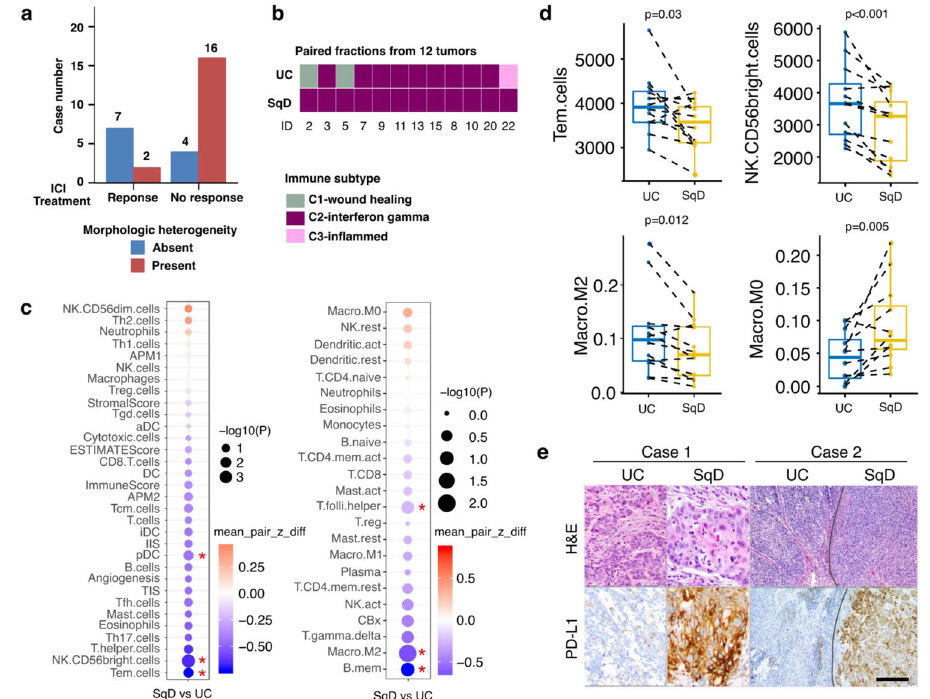
Fig. 4 | Distinct immune response gene signatures in paired UC and SqD sam- ples. a Morphologic heterogeneity was associated with a lack of clinical bene fi t in bladder cancer patients treated with the anti-PD-L1 antibody atezolizumab( n =29) ( p =0.01, Fisher ’ s exact test). b RNAseq data was used to classify the UC and SqD componentsfromthe12UC-SqDpairsbasedonTCGAimmunesubtypes. c Immune cell deconvolution analysis was performed using single sample Gene Set Enrich- ment analysis (ssGSEA, left) or the CIBERSORTX algorithm (right). The size of the circles is re fl ective of the p -value and the red * indicates signi fi cantly enriched immune cellsin either the SqD or UCfractions (two-sided Paired sampleWilcoxon test). d Immune cell deconvolution scores for individual UC-SqD paired regions were plotted for signi fi cantly enriched immune cell types identi fi ed by either